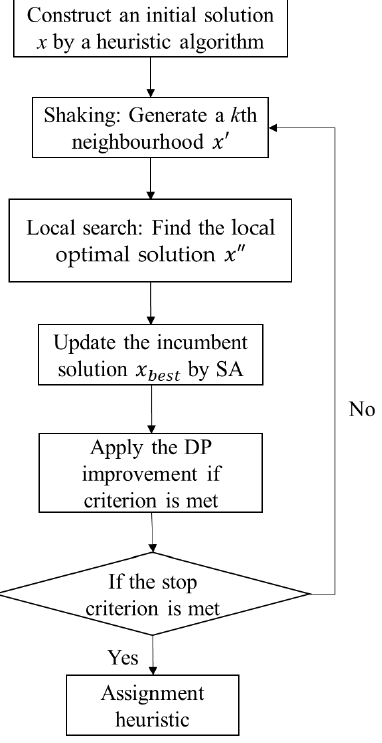
Figure 7. The flow chart of the proposed VNS-DP.